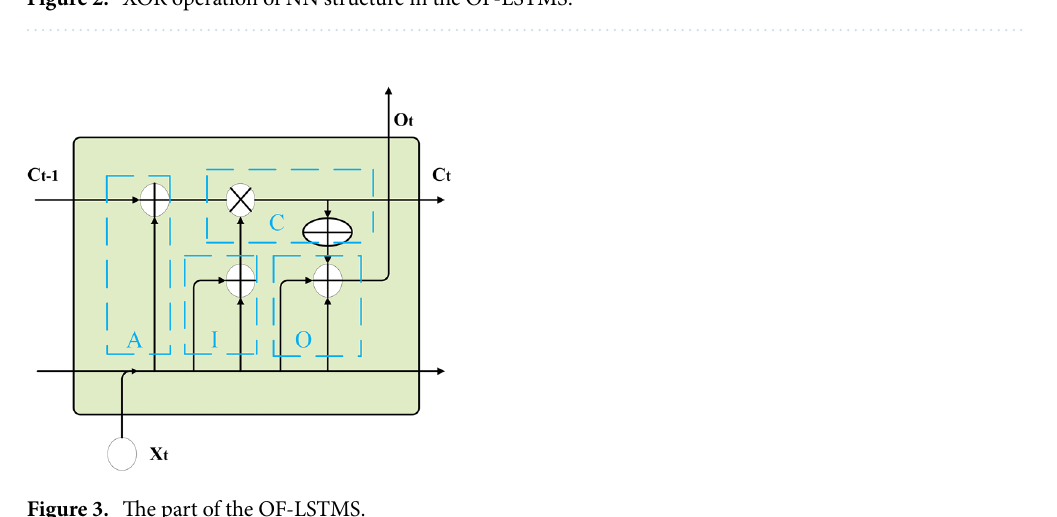
Figure 2. XOR operation of NN structure in the OF-LSTMS.